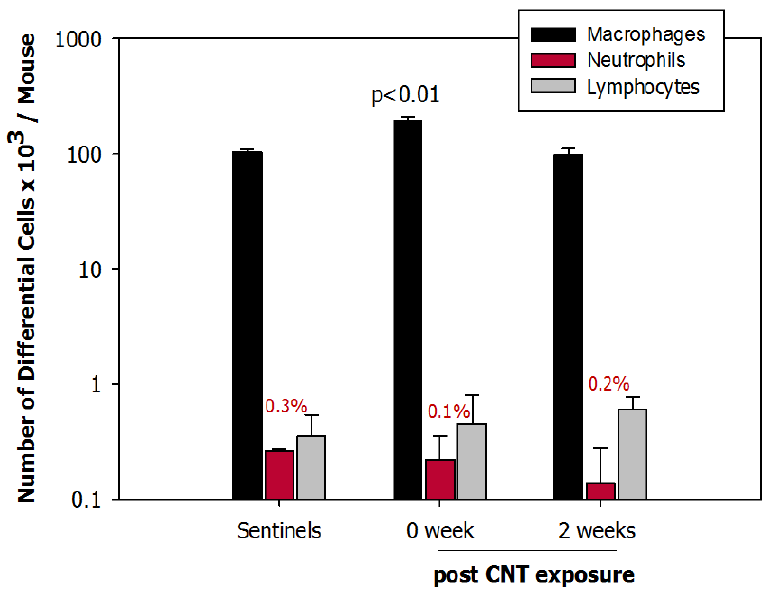
Figure 7. Number of macrophages, neutrophils and lymphocytes in bronchoalveolar lavage (BAL) fluid in controls (sentinels), animals exposed to carbon nanotube (CNT) euthanized immediately (0 week) or 2 weeks post exposure (2 weeks).